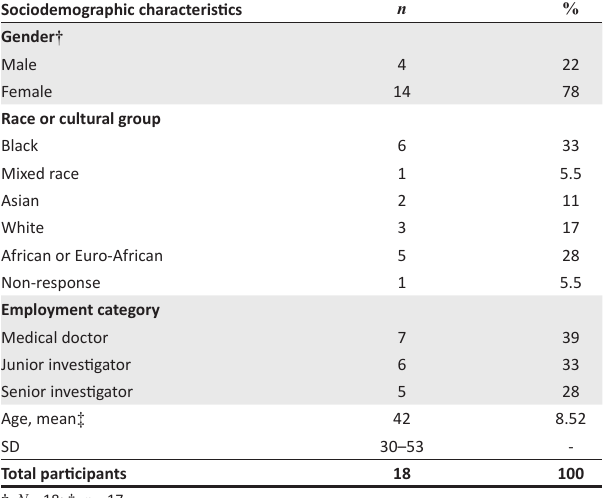
TABLE 1: Sociodemographic characteristics of study